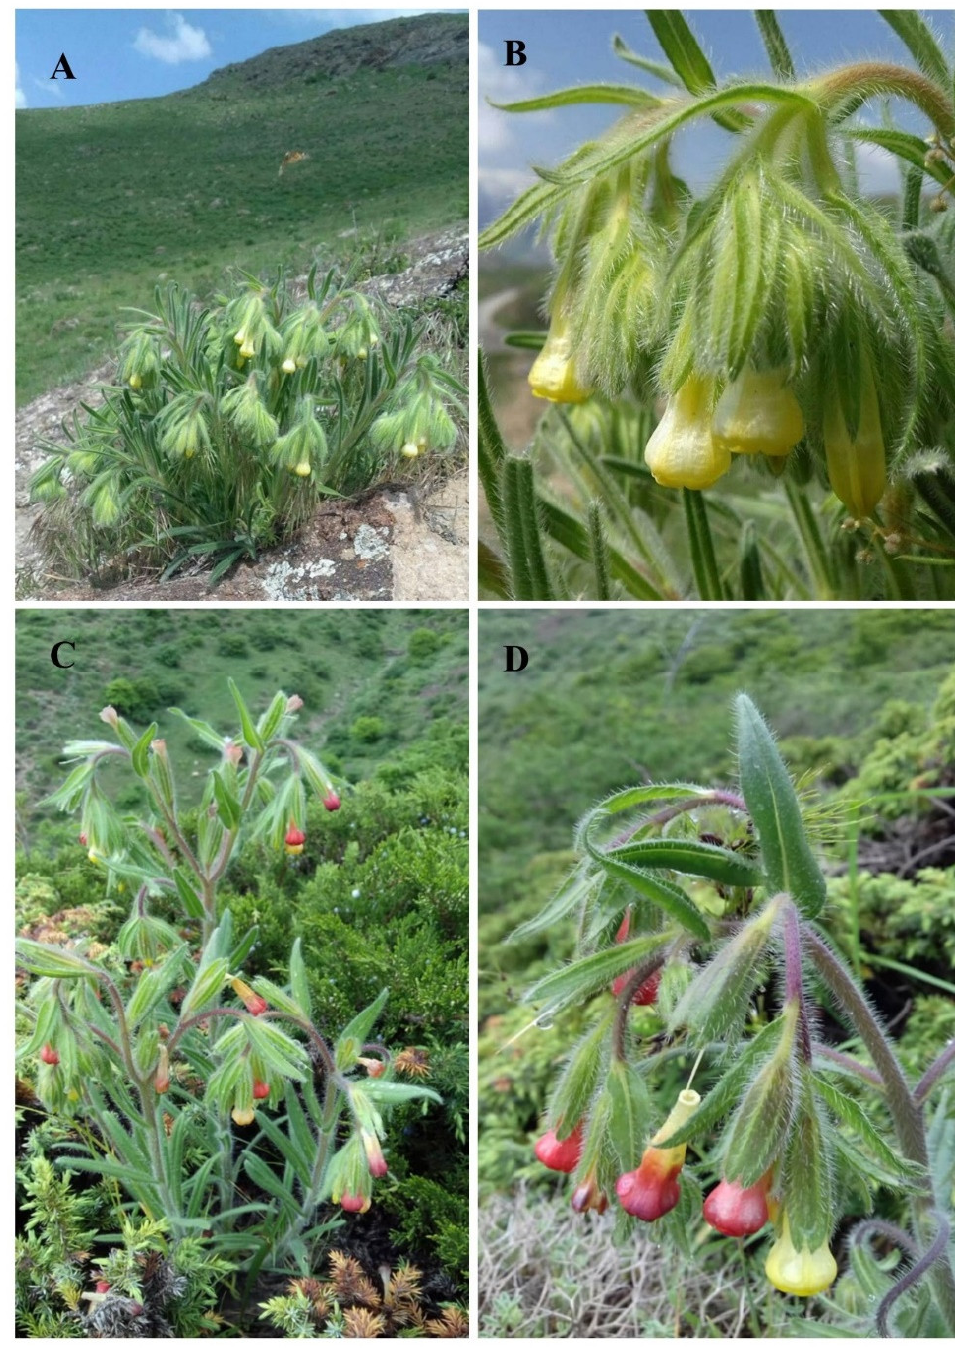
Figure 2. ( A , B ) . Onosma setosa Ledeb. with yellow coloring corolla ( C , D ). Floral color change in some taxa belong to Onosma setosa Ledeb. (Their habitats in the mount Damavand, near Rineh).